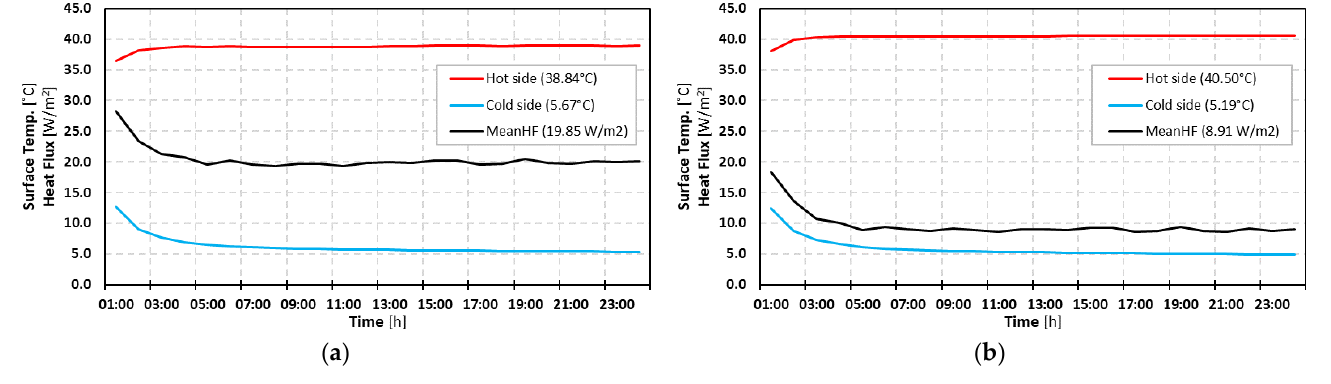
Figure 5. Measured surface temperatures and variations in heat flux densities over time when sensors are located at top height (see Figure 4b), for the reference LSF facade wall. ( a ) Sensors ’ position 1 — stud. ( b ) Sensors ’ position 2 — cavity.